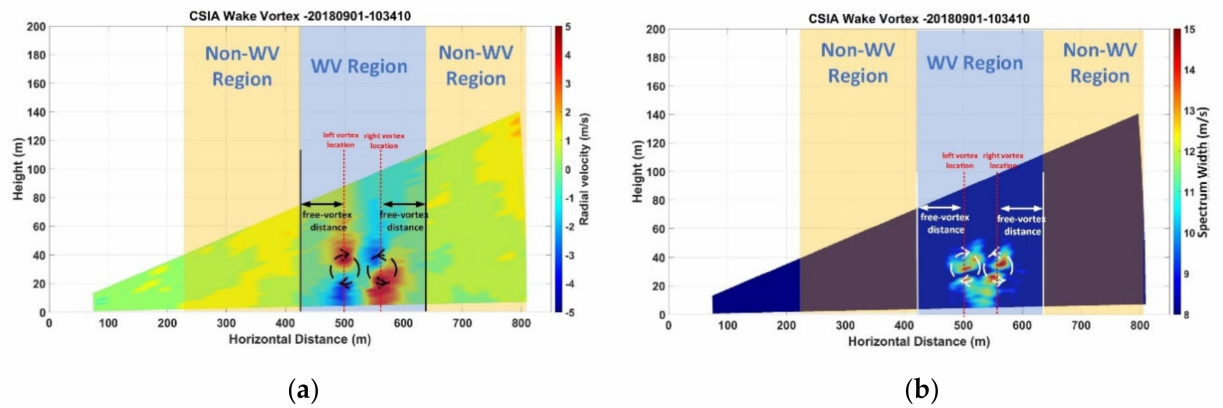
Figure 7. Wake vortex region and non-wake vortex region in ( a ) radial velocity distribution, and ( b ) spectrum width distribution of PCDL